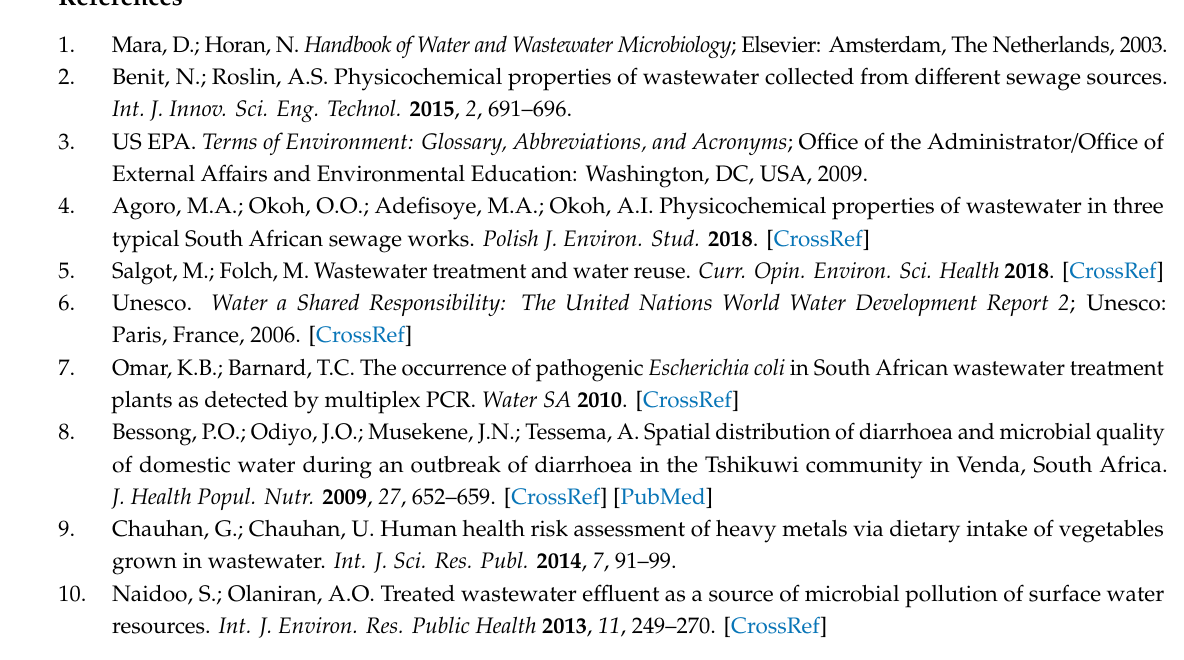
Table S1: Wastewater treatment plant (WWTP) removal e ffi ciency with standard